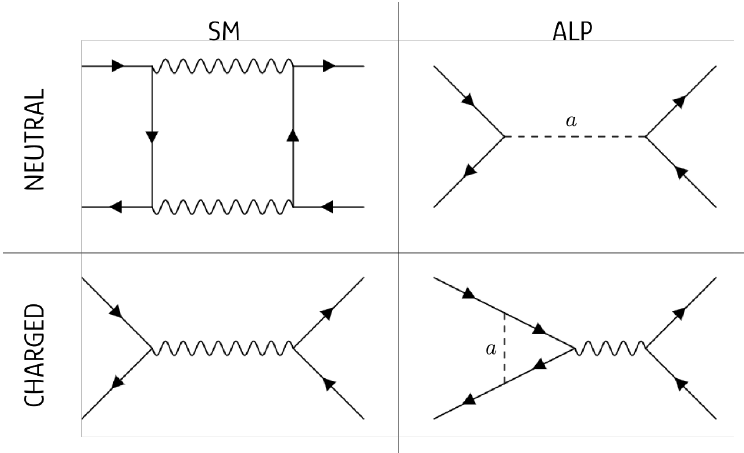
Figure 1. Sketchy illustrations of flavour-changing neutral and charged currents in the SM vs. those induced by flavour-non-diagonal ALP couplings. The wiggly lines denote SM electroweak gauge bosons, and all processes depicted are assumed to change